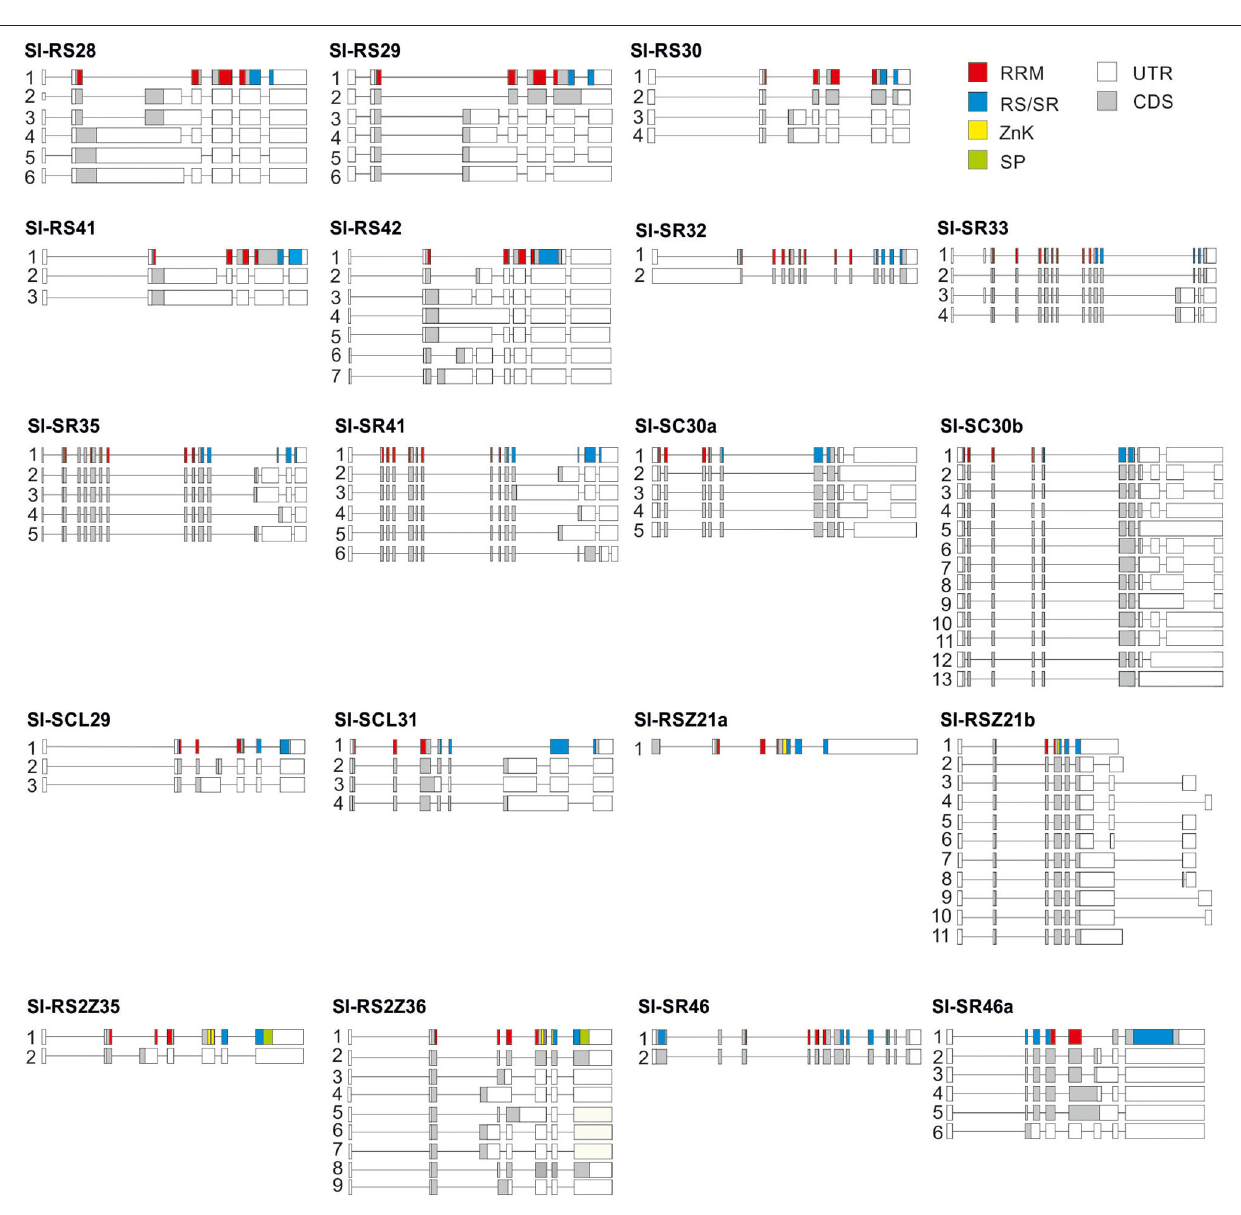
FIGURE 4 | Gene models and splice variants of tomato SR and SR-like coding genes. Isoforms were identified by analysis of RNA-Seq databases from roots, red ripe fruits and pollen ( Supplementary Dataset 2 ). Boxes indicate exons. Translated regions are colored and untranslated white. Color coding for domains is indicated on the upper